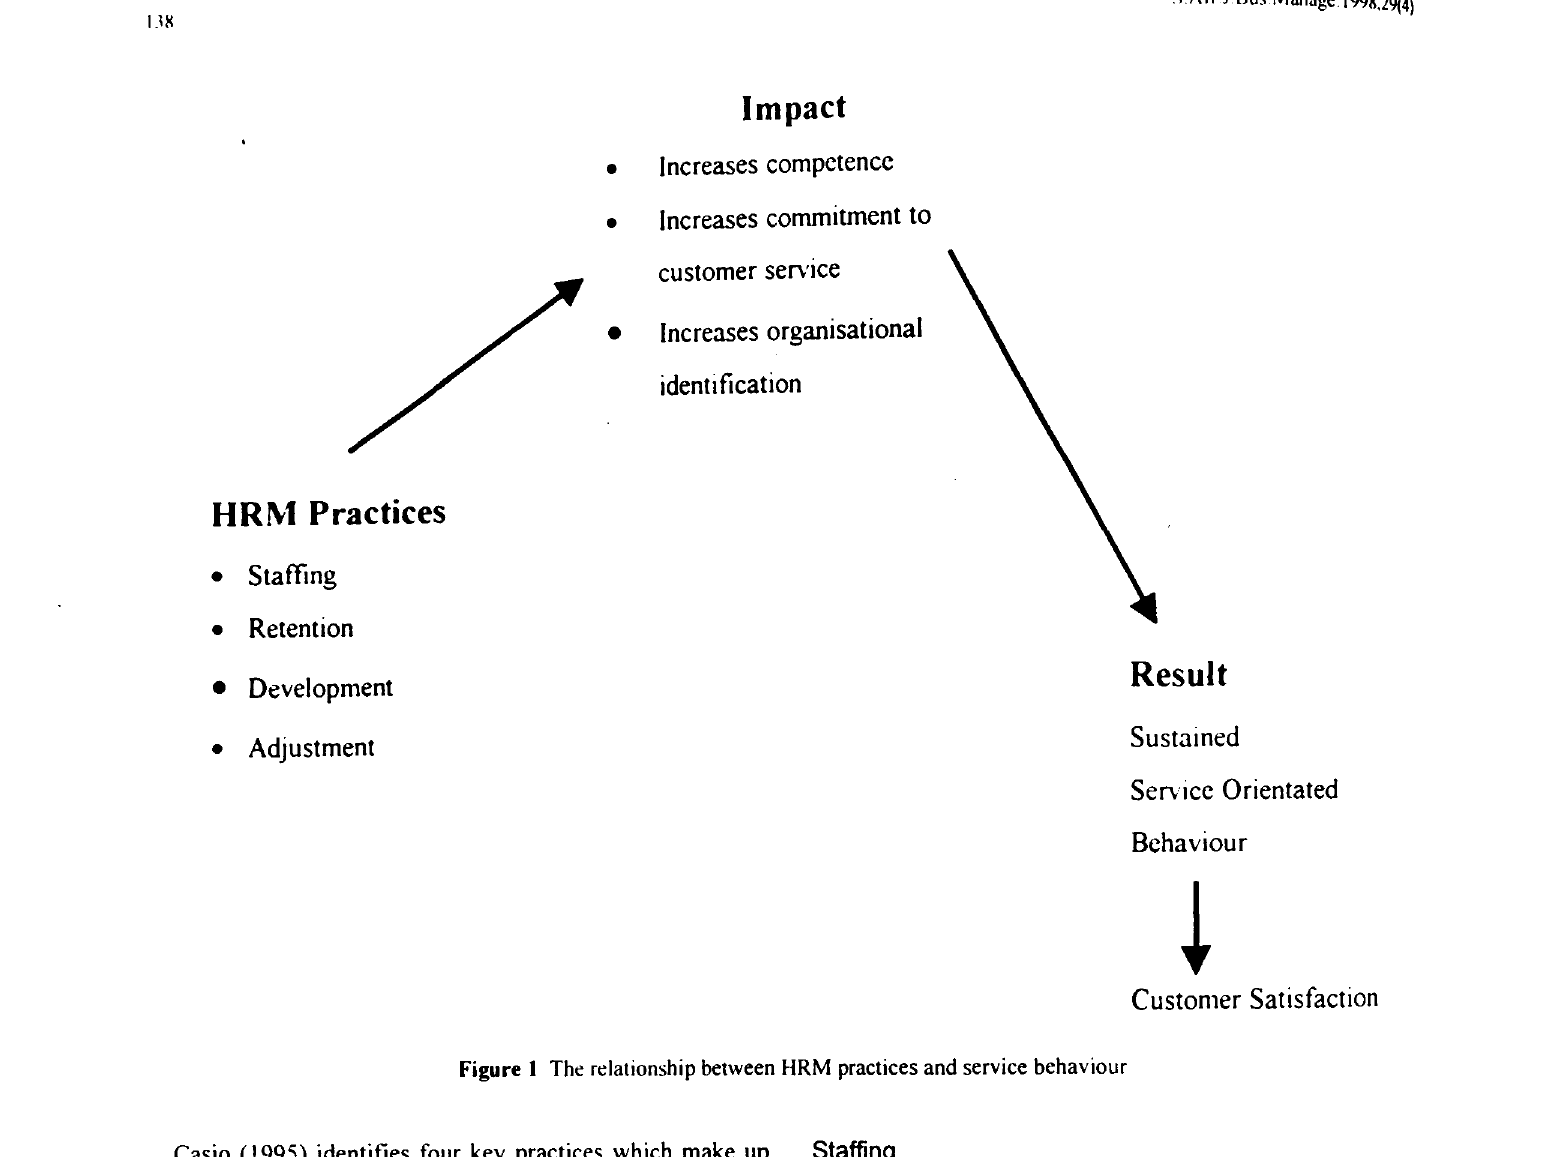
Figure I The relationship between HRM practices and service